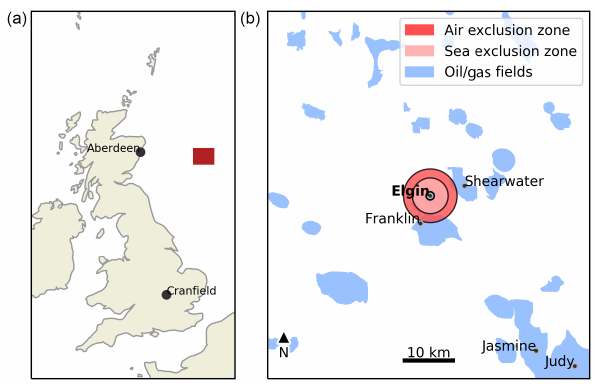
Figure 1. Map showing the location and details of the Elgin field and platform. Panel (a) shows the location of the field in the North Sea, with the red rectangle shown on panel (b) . The black dot indi- cates the location of the Elgin platform with the grey dots showing the location of neighbouring